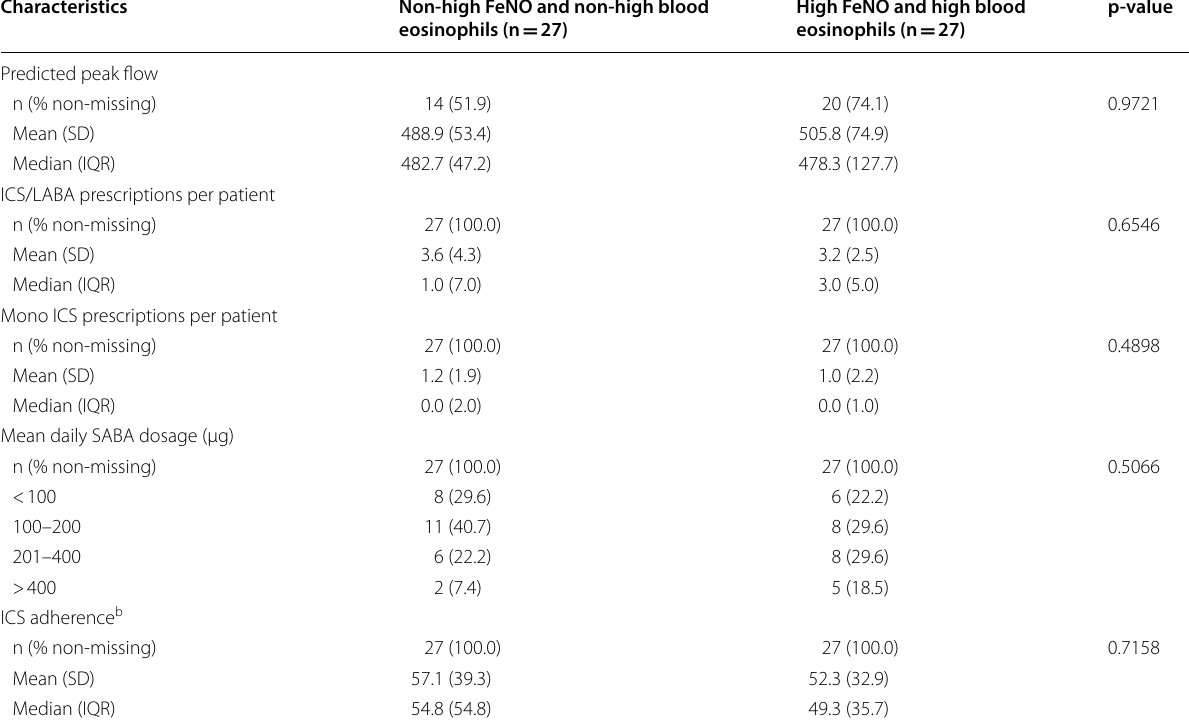
tional file 1: Table S3). While both groups demon- strated a clear trend towards greater exacerbation rates (1.41 [95% CI: 0.91, 2.19], p 0.124 and 1.35 [95% = CI: 0.99, 1.84], p 0.054, respectively) in comparison = with the reference group, this did not reach statisti- cal significance (Fig. 3). For the high FeNO and high blood eosinophil cohort (both biomarkers elevated), although the mean number of exacerbations was not significantly different from that in the reference group Table S3), a significantly greater exacerbation rate was observed (1.72 [95% CI: 1.00, 2.93], p 0.050) com- = pared with the reference group (Fig.